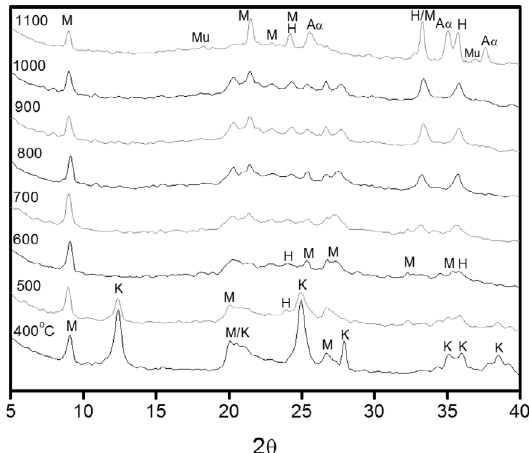
Figure 10. XRD patterns of the clay fraction fired at temperatures from 400 to 1100°C. A = α-Alumina; H = Hematite; K = kaolinite; α M = micaceous mineral; Mu = mullite; Pl = plagioclases; Q = quartz.